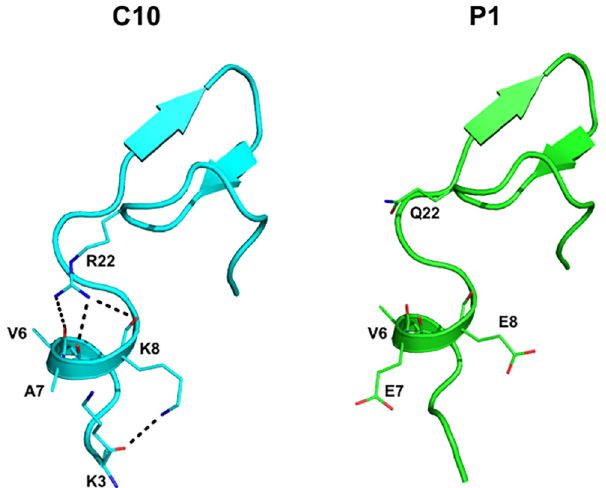
Fig 7. Structural comparison of C10 and P1 at N-termini. C10 undergoes additional interactions through R22 and K8. The nitrogen, oxygen and carbon atoms of C10 are colored blue, red and cyan, respectively, whereas P1 is illustrated with the carbon, oxygen and nitrogen atoms in green, red and blue, respectively. Grey dashes represent hydrogen